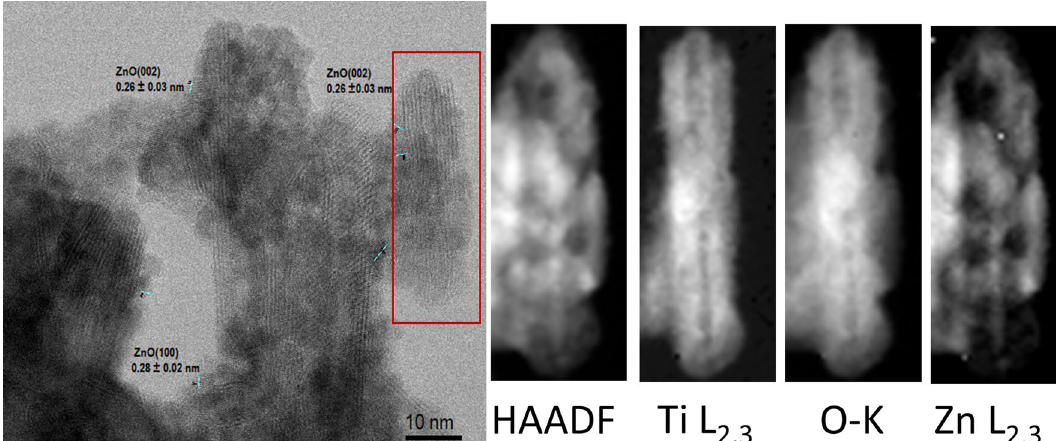
Figure 8. STEM micrography and Electron energy loss spectral (EELS) of T3. From left to right, bright field (BF- obtained prior to carrying out the EELS acquisition), high-angle annular dark-field (HAADF); Ti-L 2,3 , O-K and Zn-L 2,3 elemental